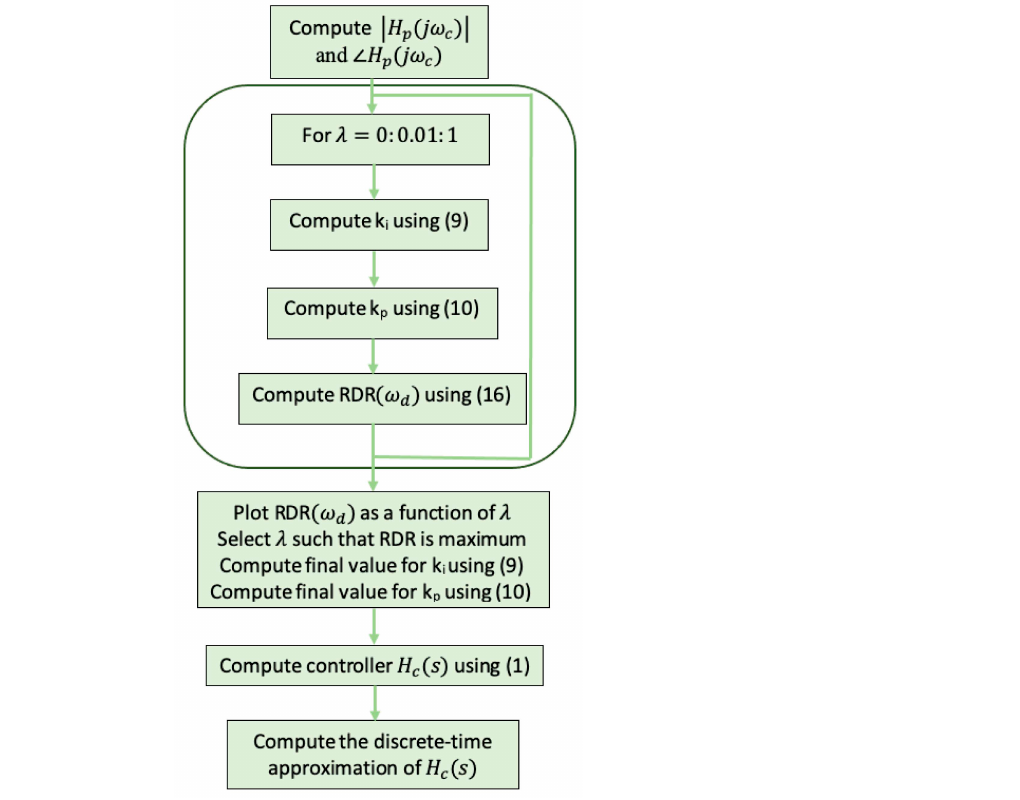
Figure 2. Tuning algorithm of FO-PI controllers for improved disturbance attenuation.